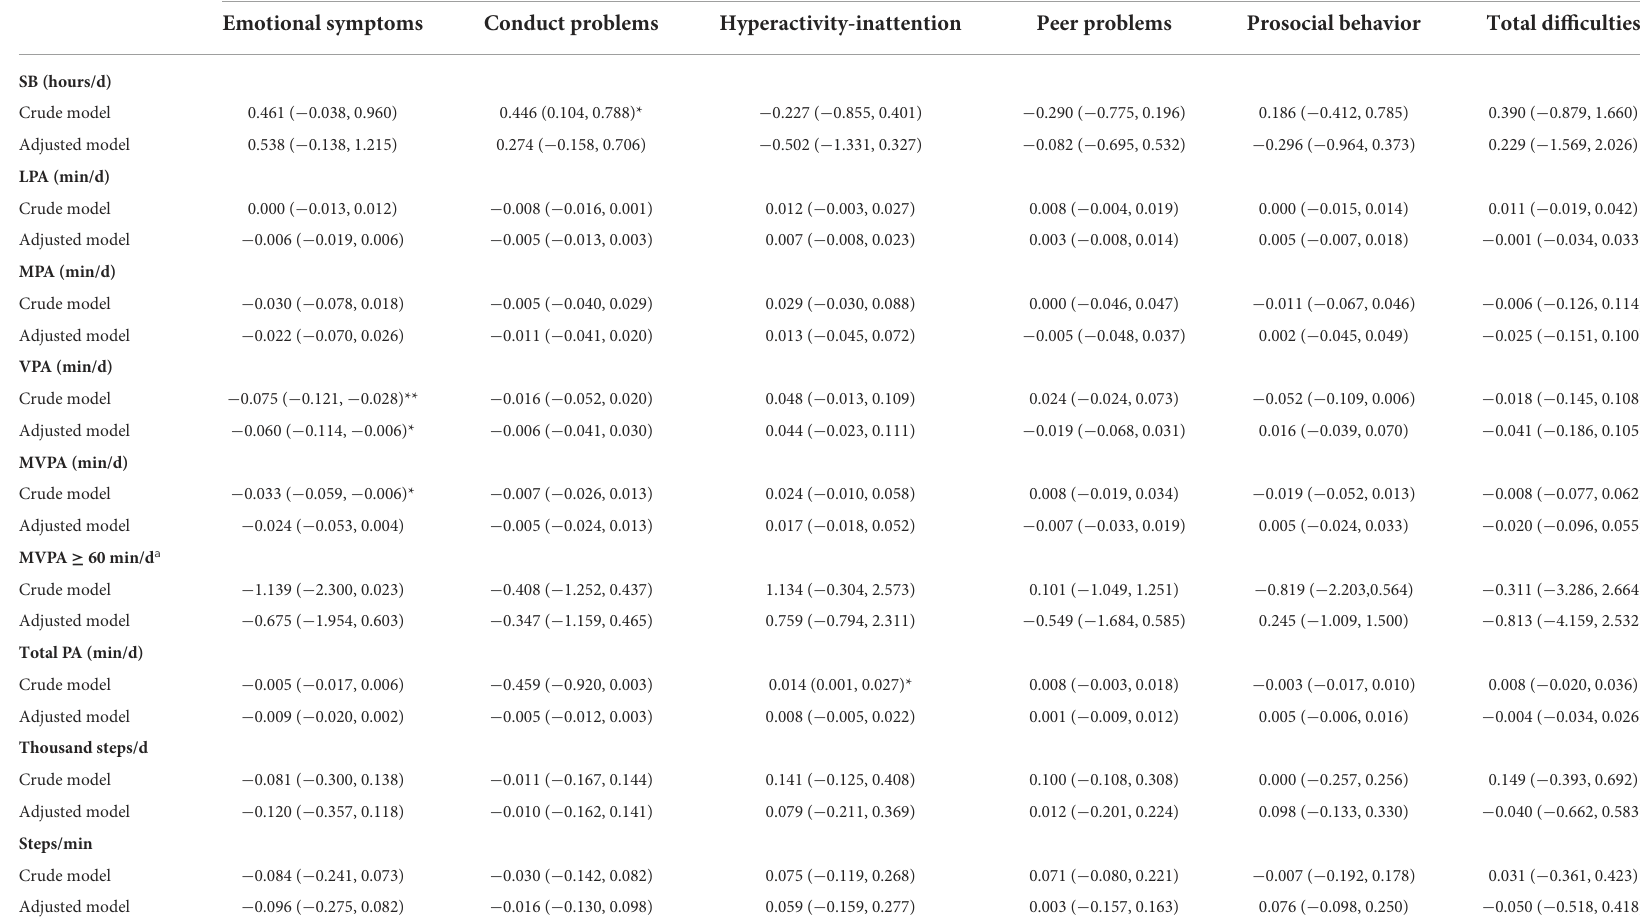
TABLE 3 Associations of the levels of emotional/behavioral problems (SDQ) with accelerometer-measured SB, PA and step counts in children with ASD ( n = 48).